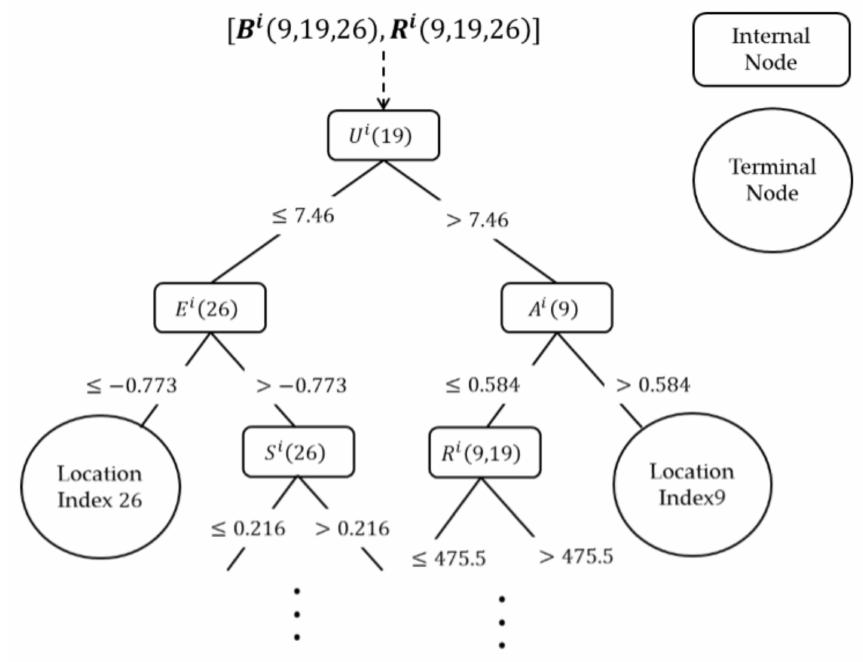
Figure 5. Example of a tree classifier for z = ( 9,19,26 ) .